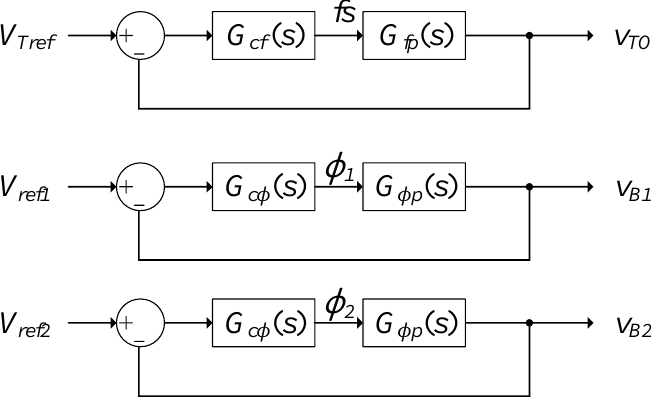
Figure 7. Control block diagram for the proposed HBDAB.